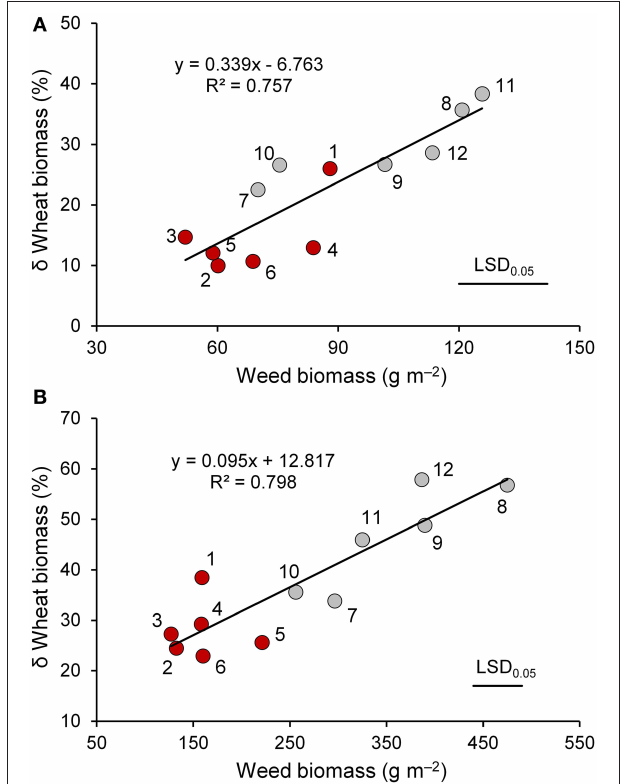
FIGURE 2 | The relationship between weed biomass and percent variation in biomass of wheat genotypes (red circle, “old” genotypes; gray circles, “modern” varieties) in the presence of interspecific competition with respect to the absence of competition at the end of tillering (A) and at heading (B). 1, Biancuccia; 2, Maiorcone; 3, Realforte; 4, Russello; 5, Scorsonera; 6, Cappelli; 7, Capeiti; 8, Creso; 9, Simeto; 10, Valbelice; 11, Iride; 12,